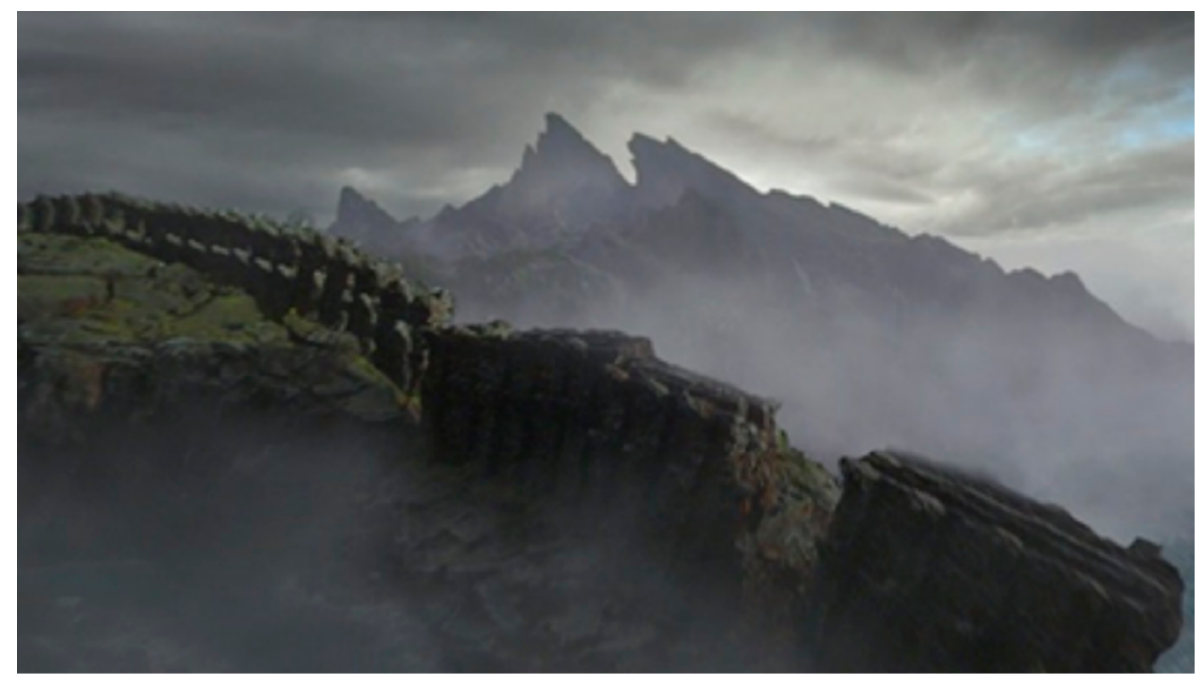
Figure 6. The wall and organic forms, exoskeleton, on the Island of the Skull (2005). https://itunes.apple.com/pl/movie/king-kong-2005/id657086845 (accessed on 1 January 2021). Finally, in the 2017 film (Figure 7), once the helicopters pass through the multiple lightning strikes and the fierce storm, they find themselves in a natural setting of several cliffs isolated by water and, after them, in the distance, a high pointed mountain with two peaks can be seen. Between these atolls, there is also a series of watery and labyrinthine meanders that slow down and visually hide the arrival to the center of the island, and become metaphors announcing what it means to move towards it. In fact, inside, a vertical palisade made of wooden logs protects and, in turn, isolates the town that is located there, while in the King Kong cave, only a small opening allows access, obstructing it.